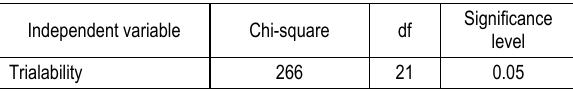
Table 6. The results of test of the relationship between trialability of solar water heater and adoption